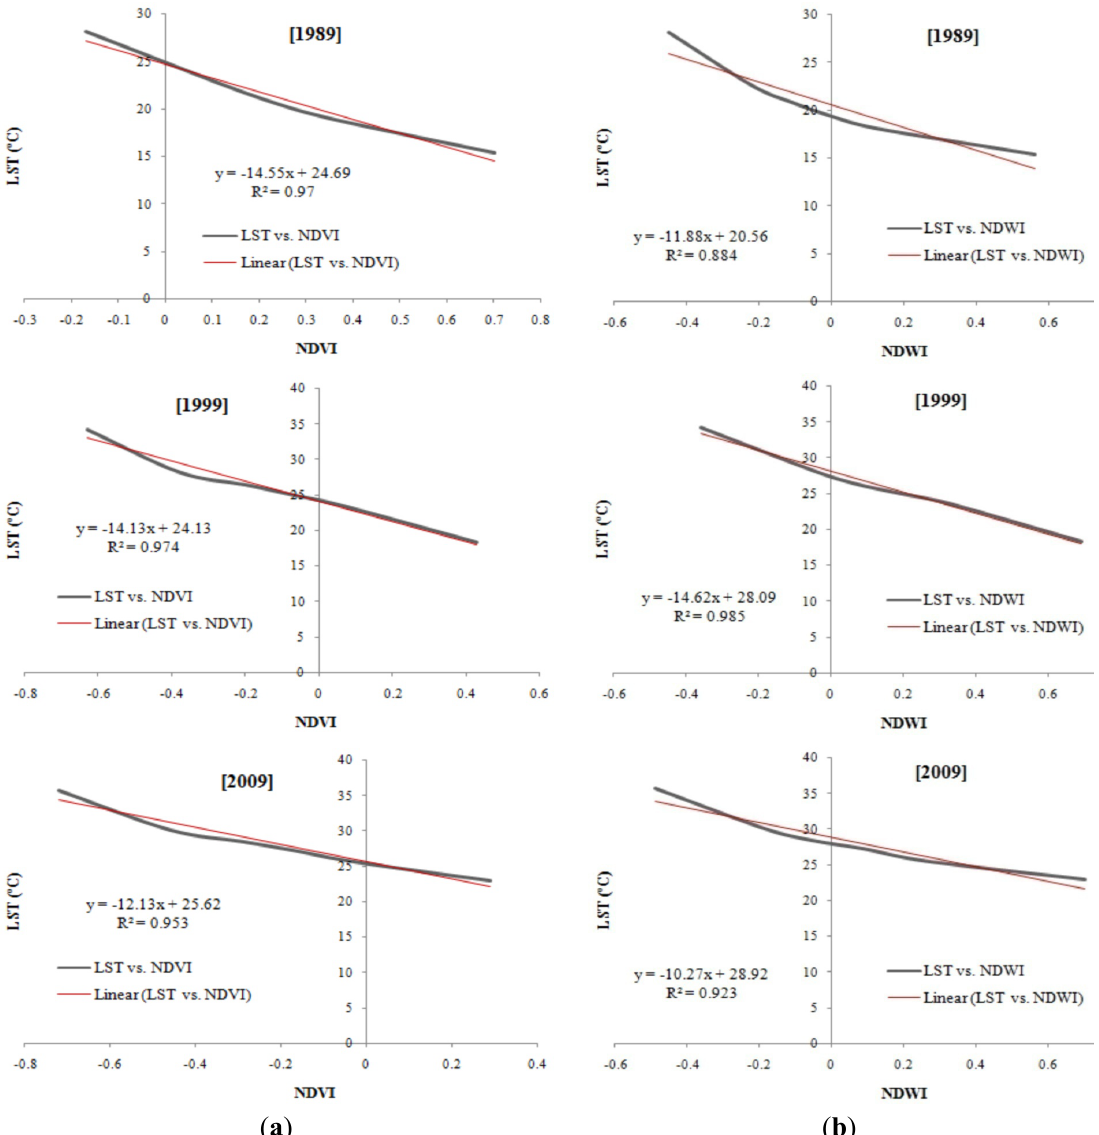
Figure 11. ( a ) Correlation between NDVI and LST; ( b ) Correlation between NDWI and